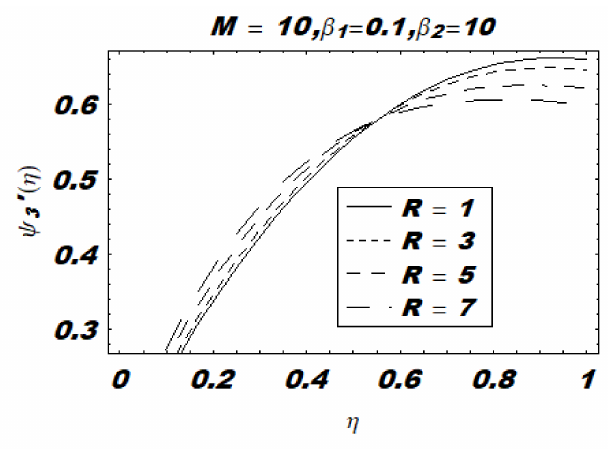
for the circular 3